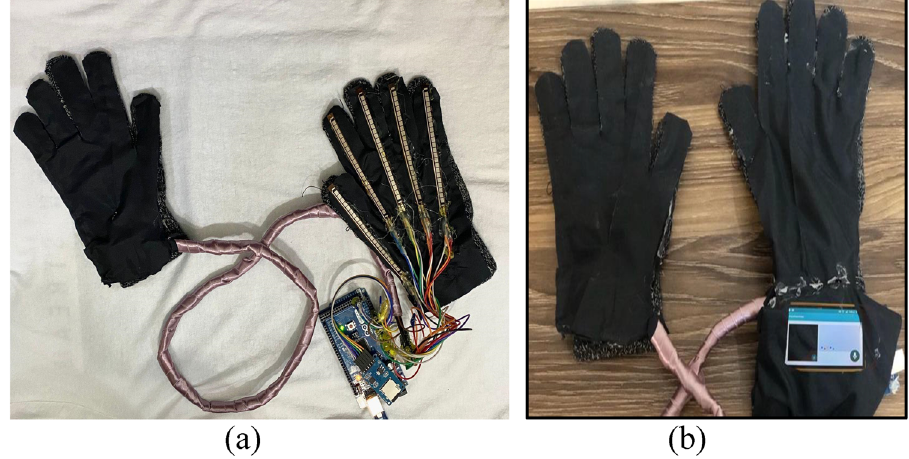
Figure 3: IGs ’ prototype. Two gloves connected to each other and the LCD ( a ) and the fi nal prototype of the IG system ( b ) .